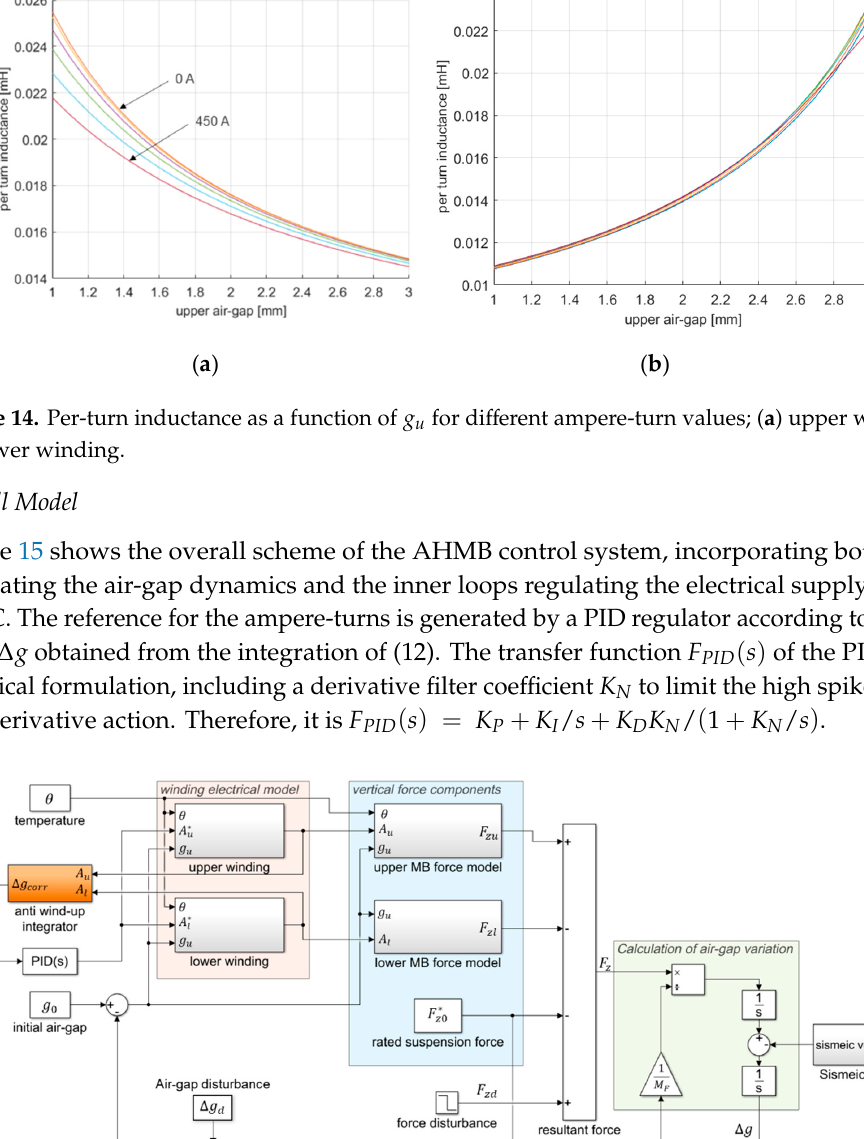
Figure 14. Per-turn inductance as a function of 𝑔 (cid:3048) for different ampere-turn values; ( a ) upper winding; ( b ) lower winding.